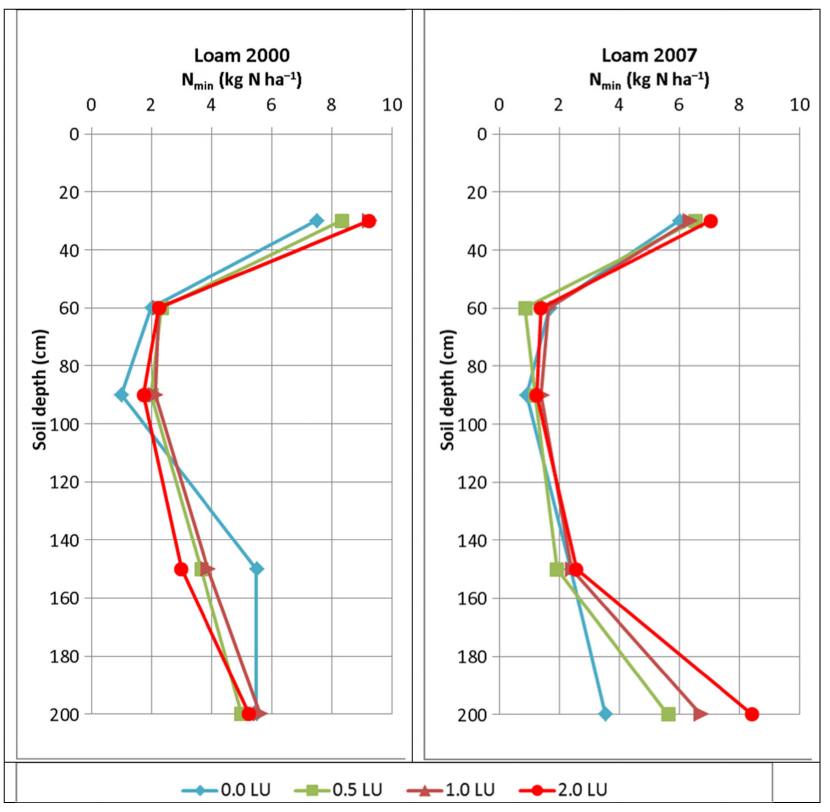
Figure 2. Temporal change of N min amounts in the depth profile between the years 2000 (on the left) and 2007 (on the right) according to differentiated fertilization intensity (in LU ha − 1 ) on loam soil (ms = ± 1.20 kg N ha − 1